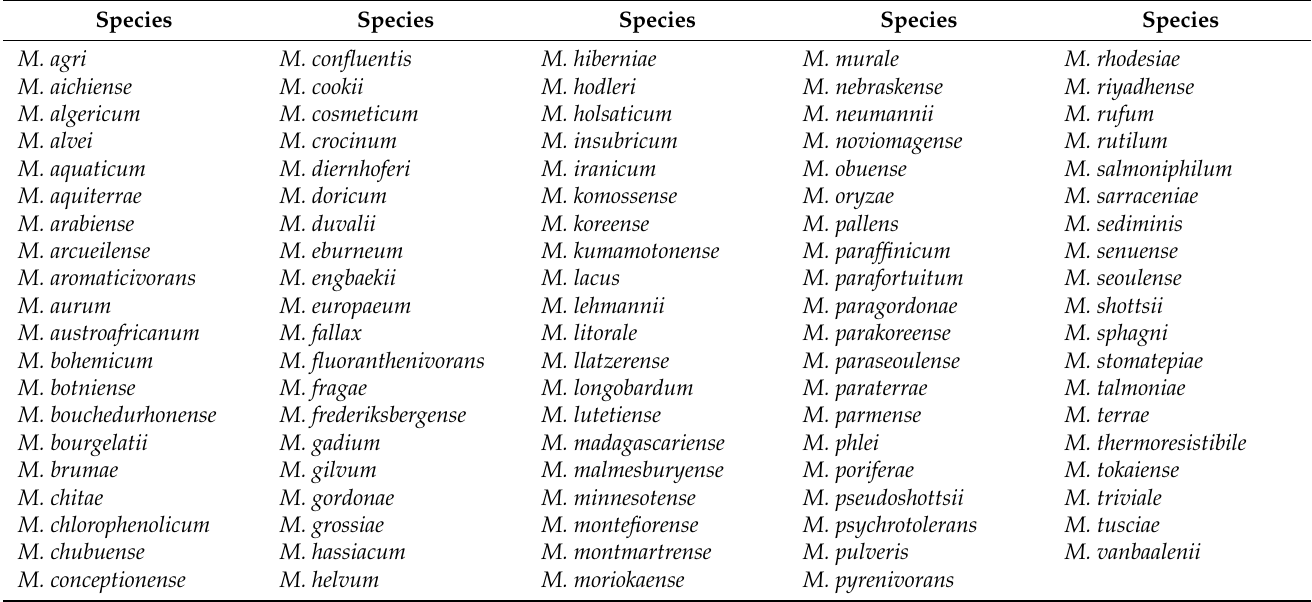
Table 4. Mycobacteria in Risk Group 1 according to European Union Directive 2000/54/EC [187]. Species Species Species Species Species